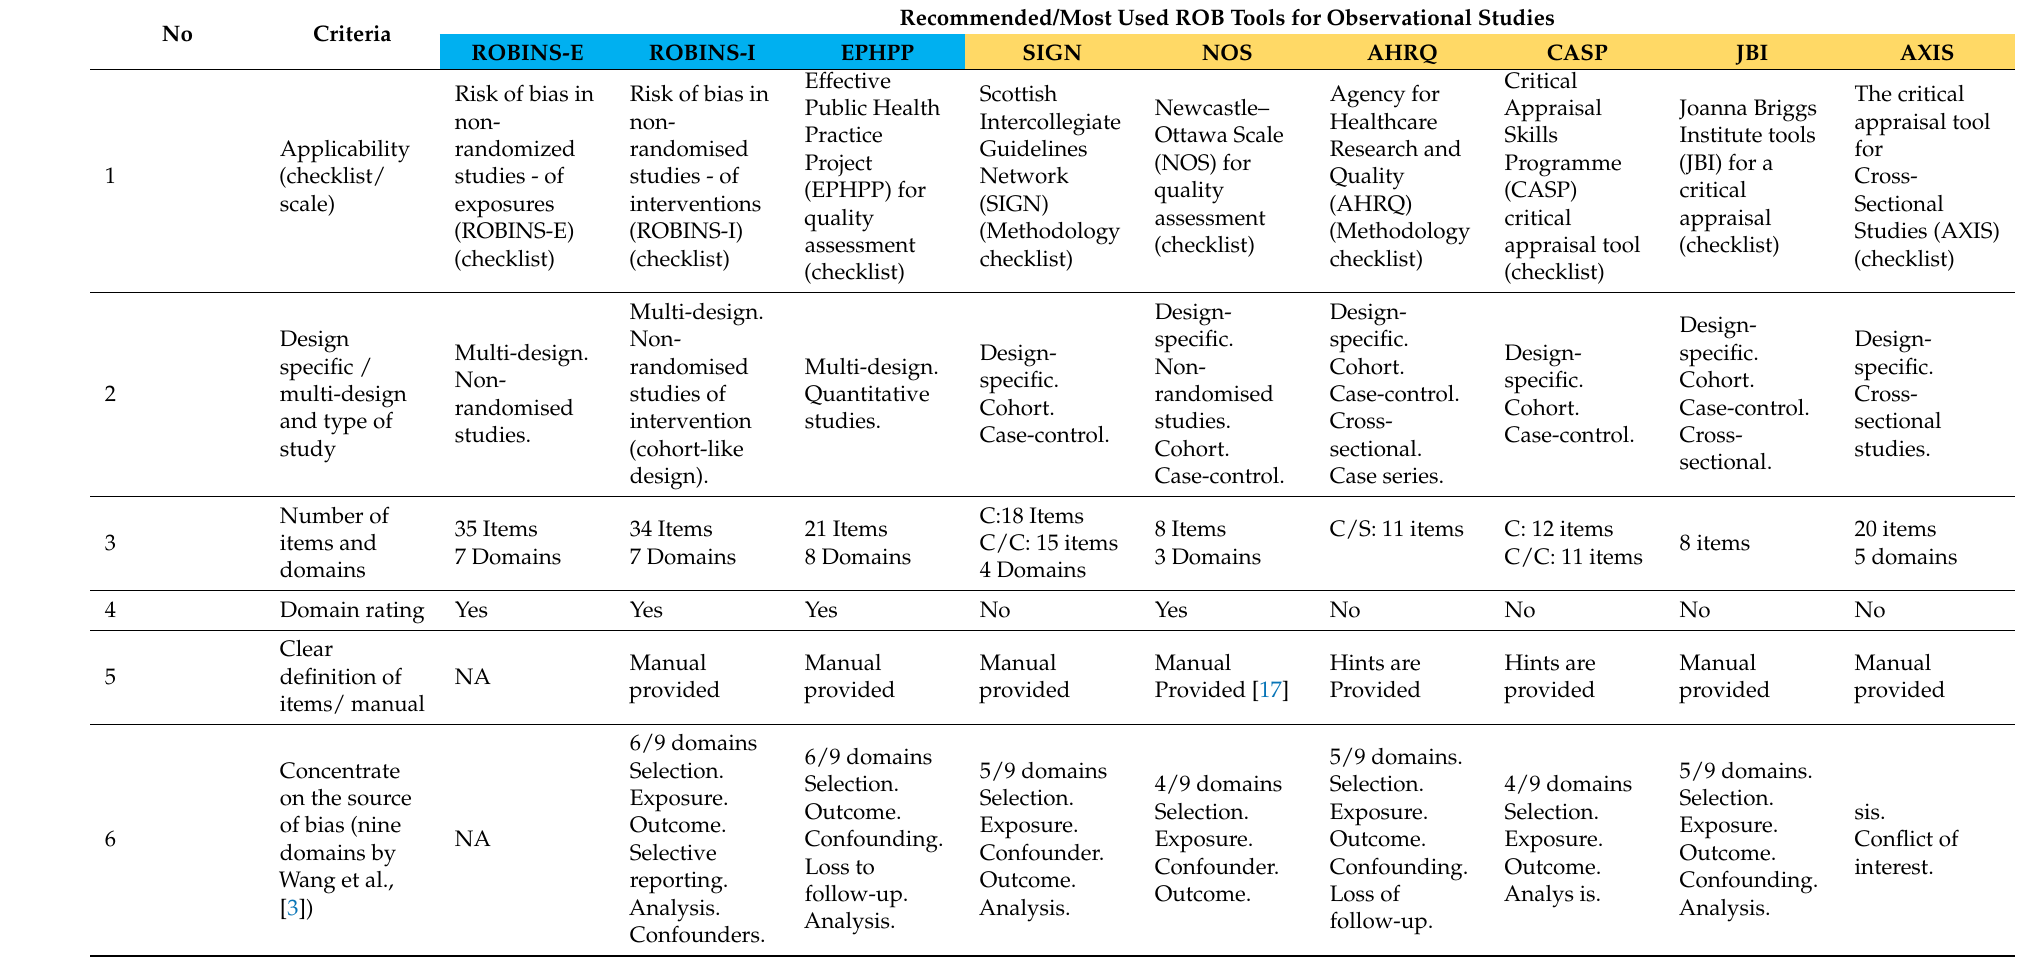
Table 3. Eight criteria of the recommended ROB tools for observational